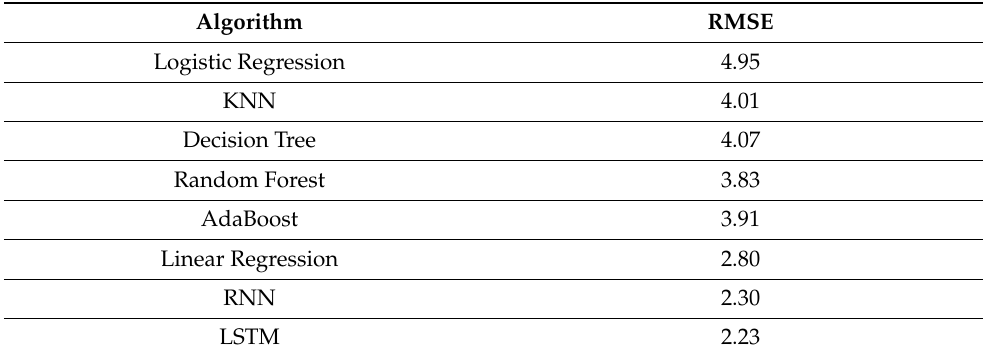
Table 1. Approximation model’s